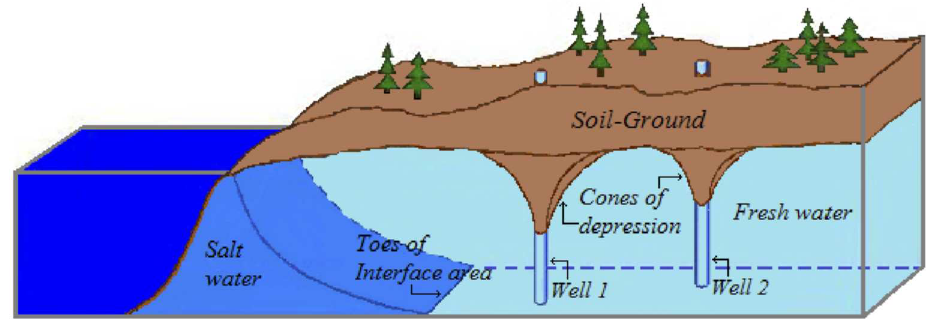
Fig 1. Schematic representation of salt water intrusion under sharp-interface and Ghyben-Herzberg